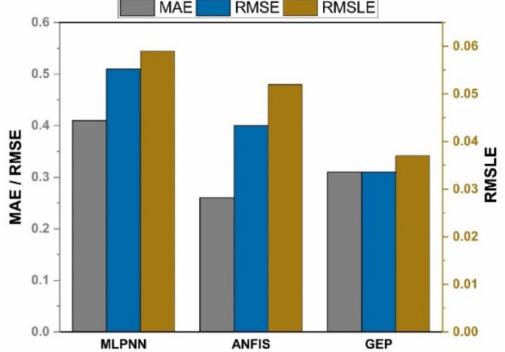
Figure 14. Comparison of errors for splitting tensile